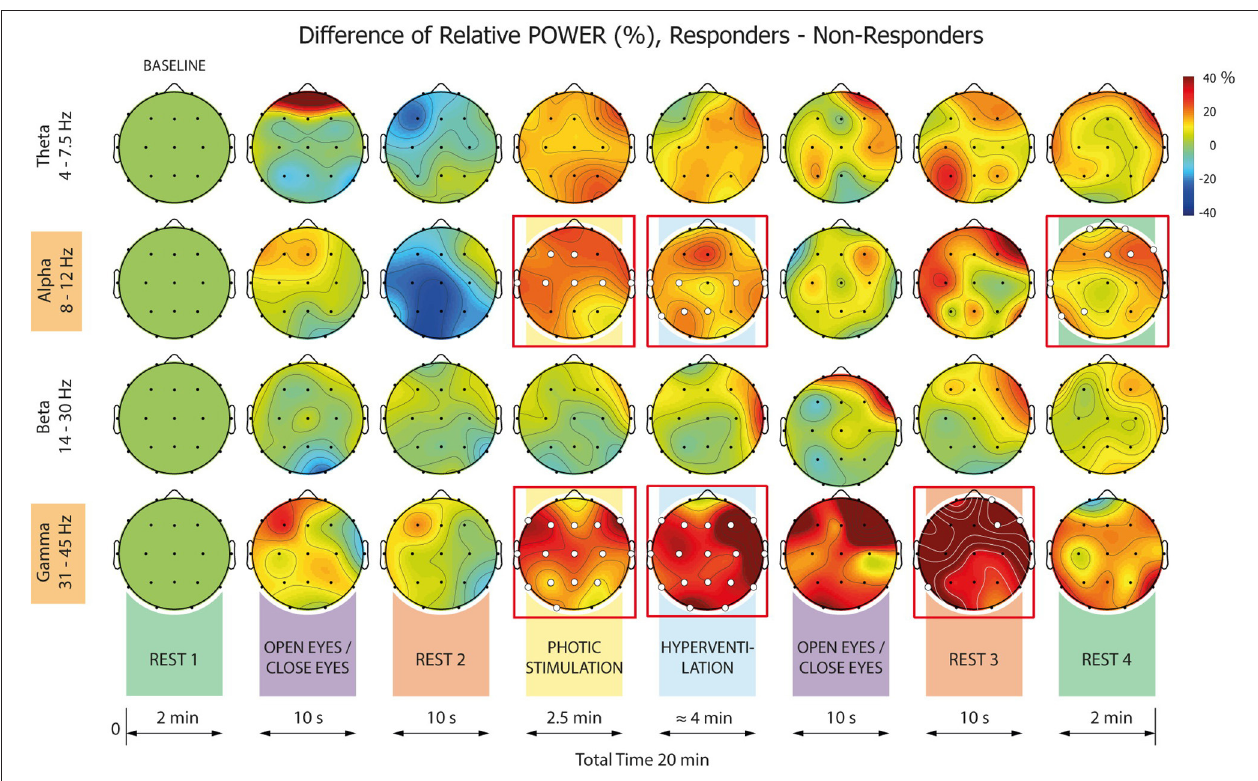
FIGURE 4 | Relative mean power (RPW) differences between Responders and Non-responders. Statistically significant or non-significant differences in a given electrode are marked by a white or black dot, respectively. The significant differences between Responders and Non-responders were identified in alpha and gamma frequency ranges only (heads in red